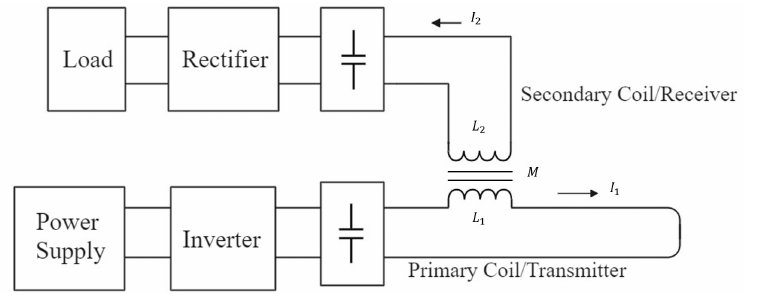
Figure 1. Configuration of CIPT